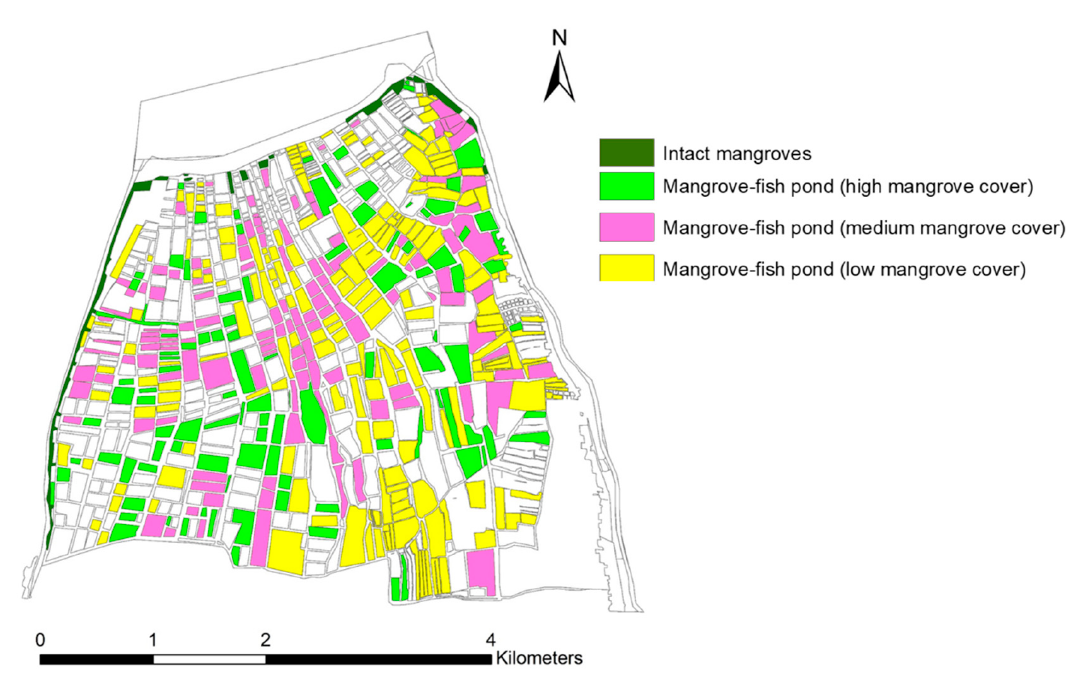
Figure 2. Map of mangrove-fish pond aquaculture in different classes of mangrove covers.